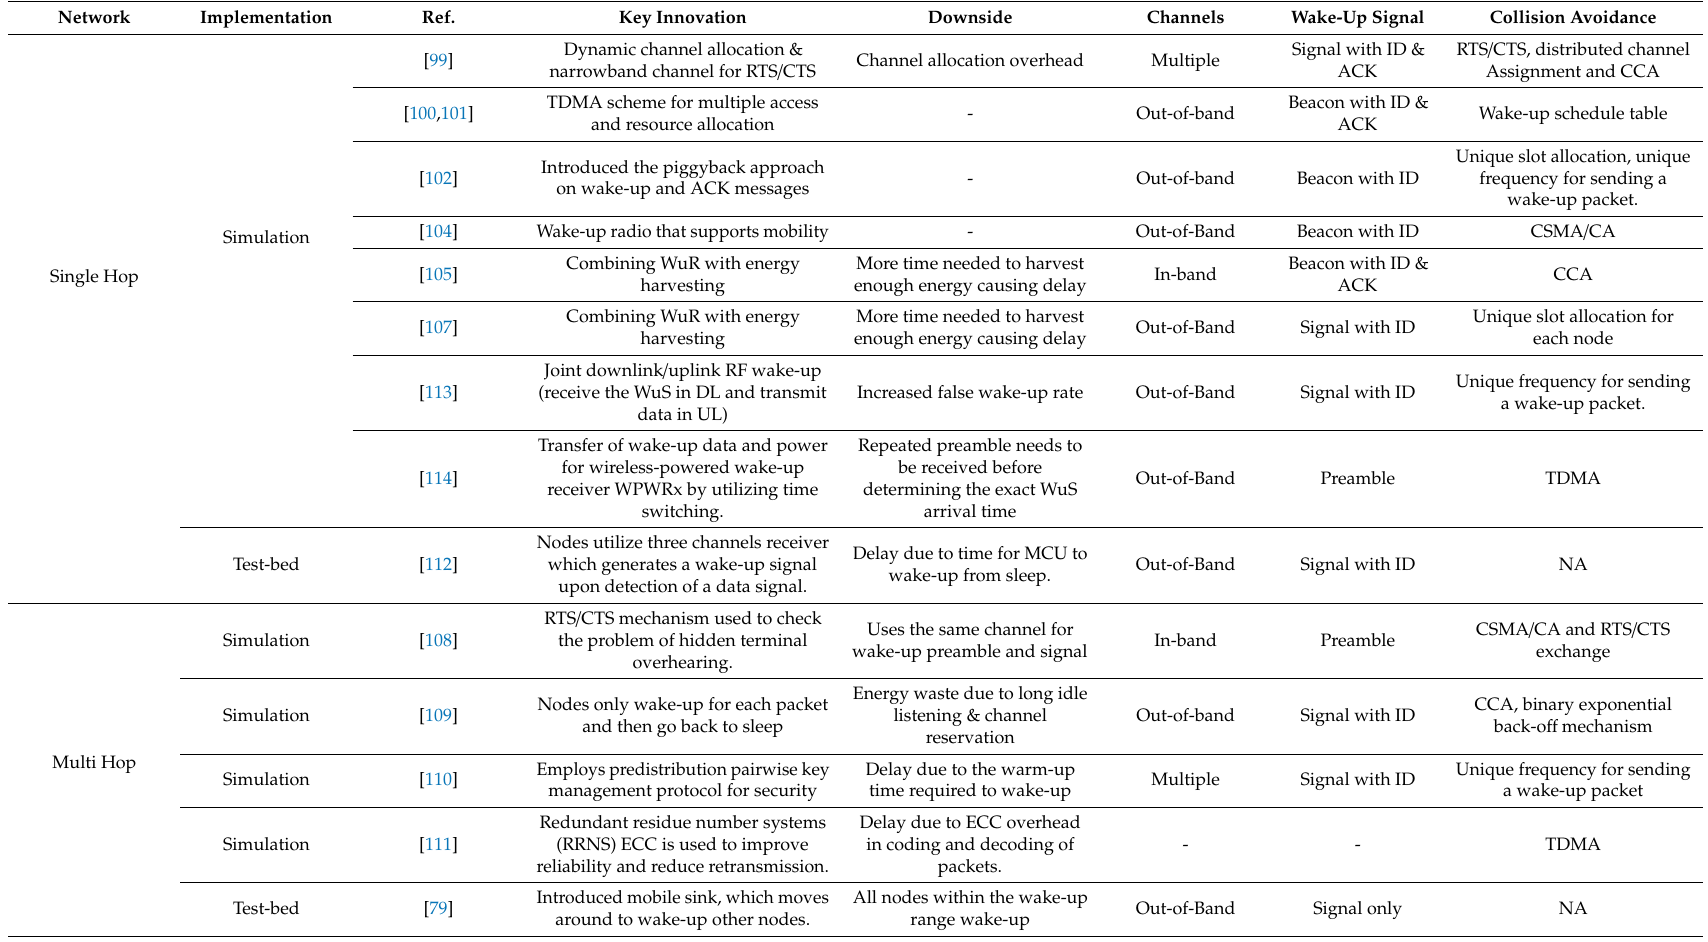
Table 2. Key features and characteristics of the MAC protocols for the wake-up